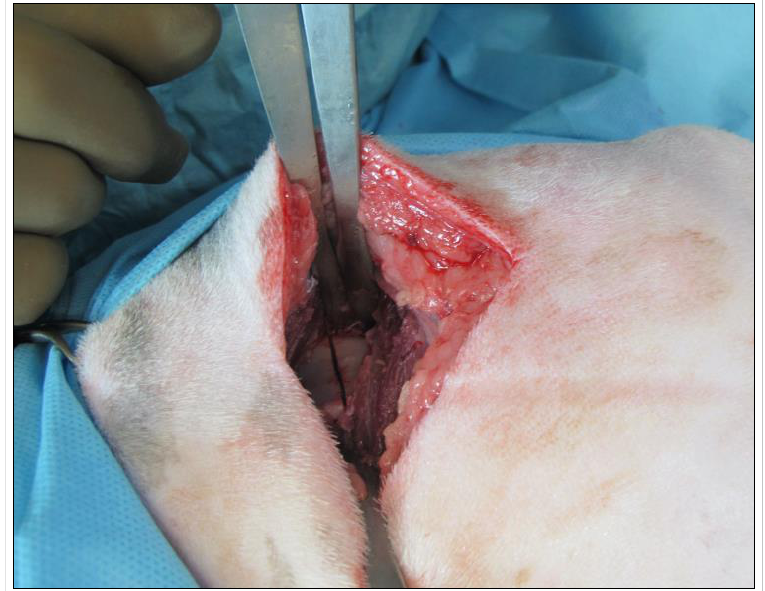
Figure 2. Intraoperative aspect of iliac osteotomy.